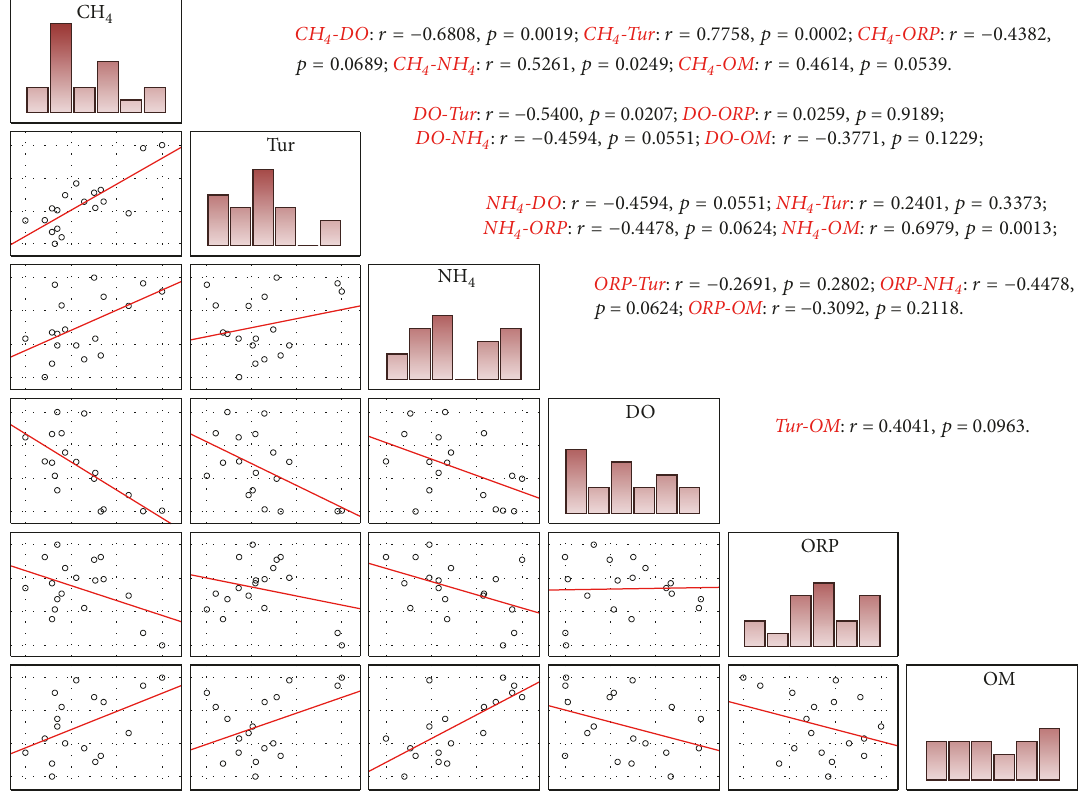
Figure 5: The linear trend between independent variables and lgCH 4